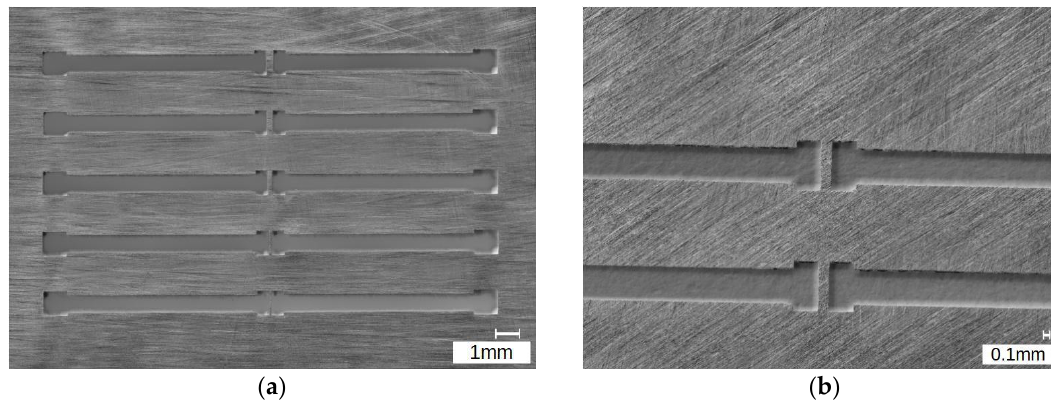
Figure 6. Shadow mask for organic field effect transistor (OFET) electrode fabrication with the channel lengths: 100, 150, 200, 250, and 300 (µm): ( a ) microscopic image (magnification ×10); ( b ) microscopic image channel length: 250 (µm), magnification ×30.